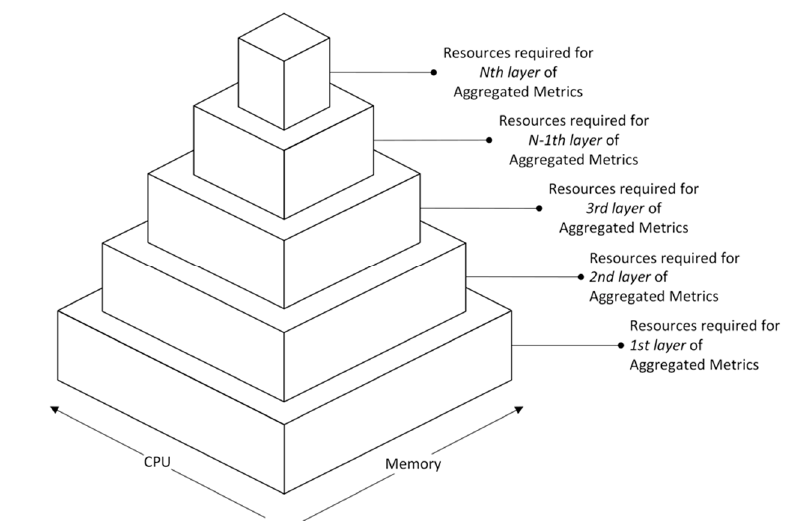
Figure 4. Aggregated Metrics hierarchy.